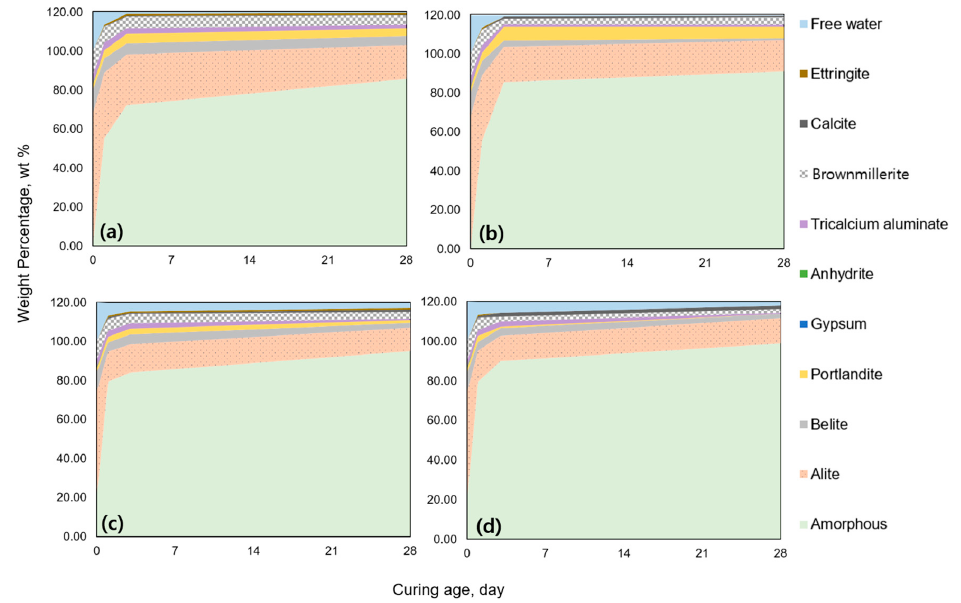
Figure 5. Phase assemblages of all the specimens from the XRD and TGA results: ( a ) C specimen, ( b ) C_HT specimen, ( c ) CS specimen, and ( d ) CS_HT specimen.